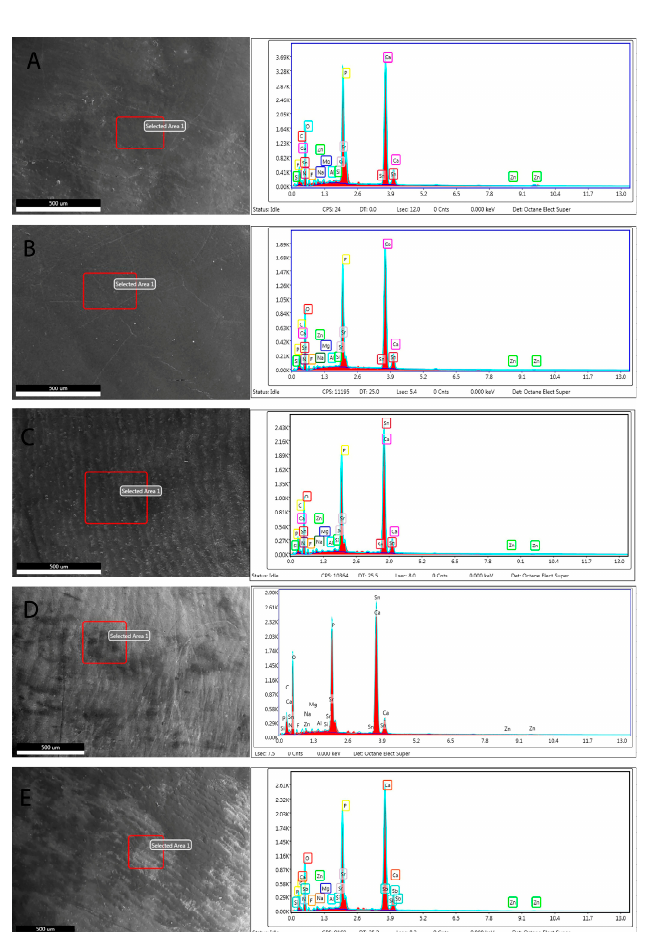
Figure 4. High resolution of XPS spectra of F 1 s for bleached enamel surface and subsequent fluor-